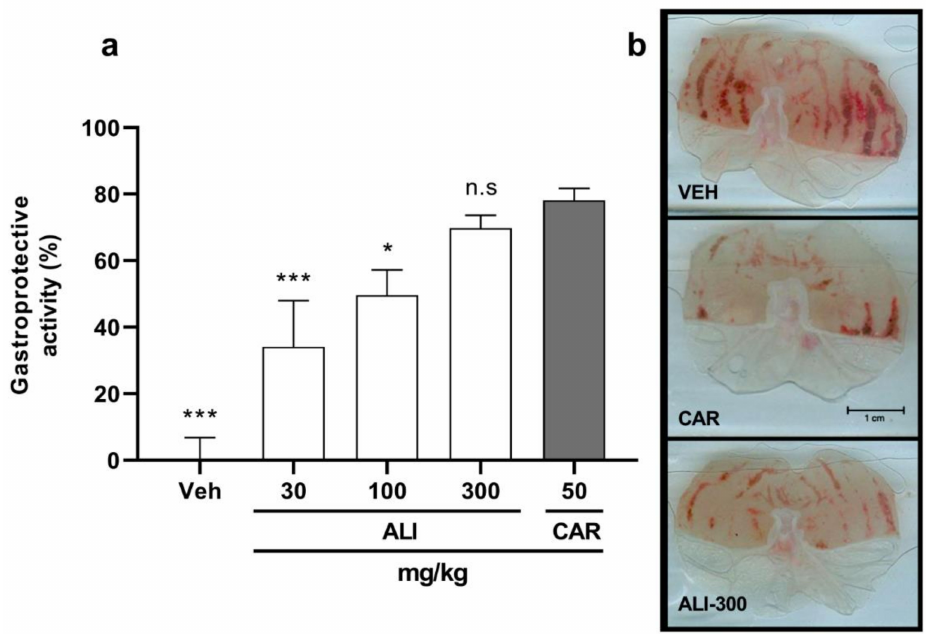
Figure 1. Gastroprotective activity of ALI in an ethanol-induced gastric ulcer model in mice. ( a ) Percentage of gastroprotec- tion in the different treatment groups. Each column represents the mean ± SEM ( n = 7 animals). An ANOVA was performed followed by Dunnet’s test. ( b ) Representative images of mice stomachs from three treatment groups. Macroscopic views of fresh dissected stomachs treated with VEH (upper panel), CAR (central panel) or ALI -300 (lower panel). Differences in hemorrhagic streaks can be observed. VEH, isotonic saline solution; CAR, carbenoxolone 50 mg/kg; ALI -300, Artemisia ludoviciana aqueous extract 300 mg/kg. * p < 0.05, *** p < 0.001, significant difference vs. CAR. n.s, no significant difference vs.